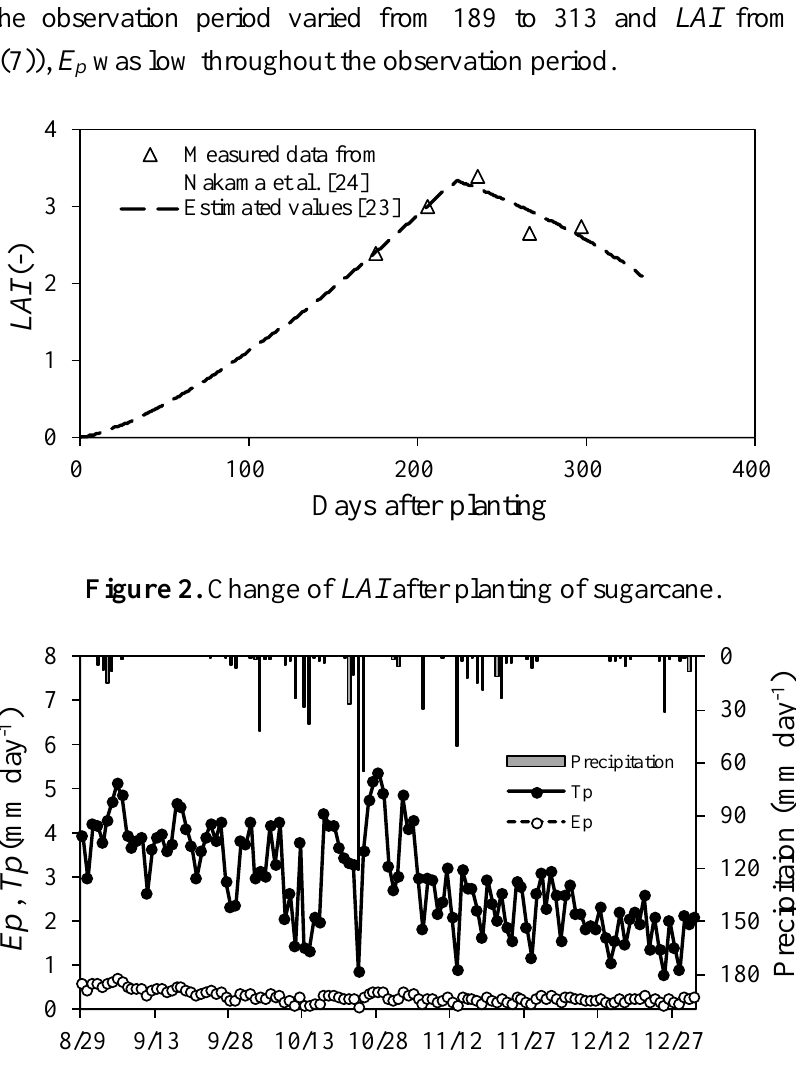
Figure 3. Daily precipitation, potential evaporation ( Ep ) and potential transpiration ( Tp ) from 29 August to 31 December